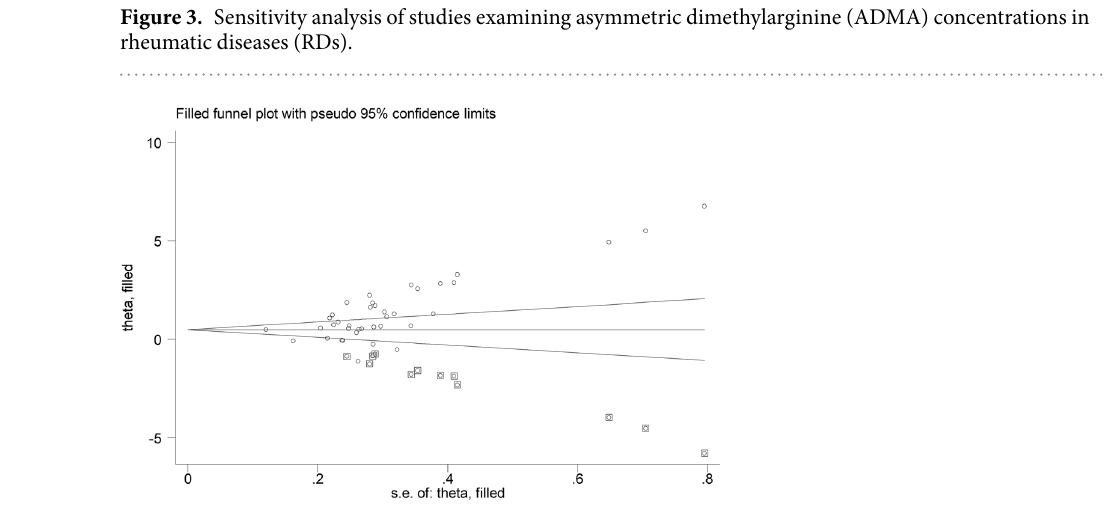
Figure 4. Funnel plot of eligible studies on dimethylarginine (ADMA) concentrations in rheumatic diseases